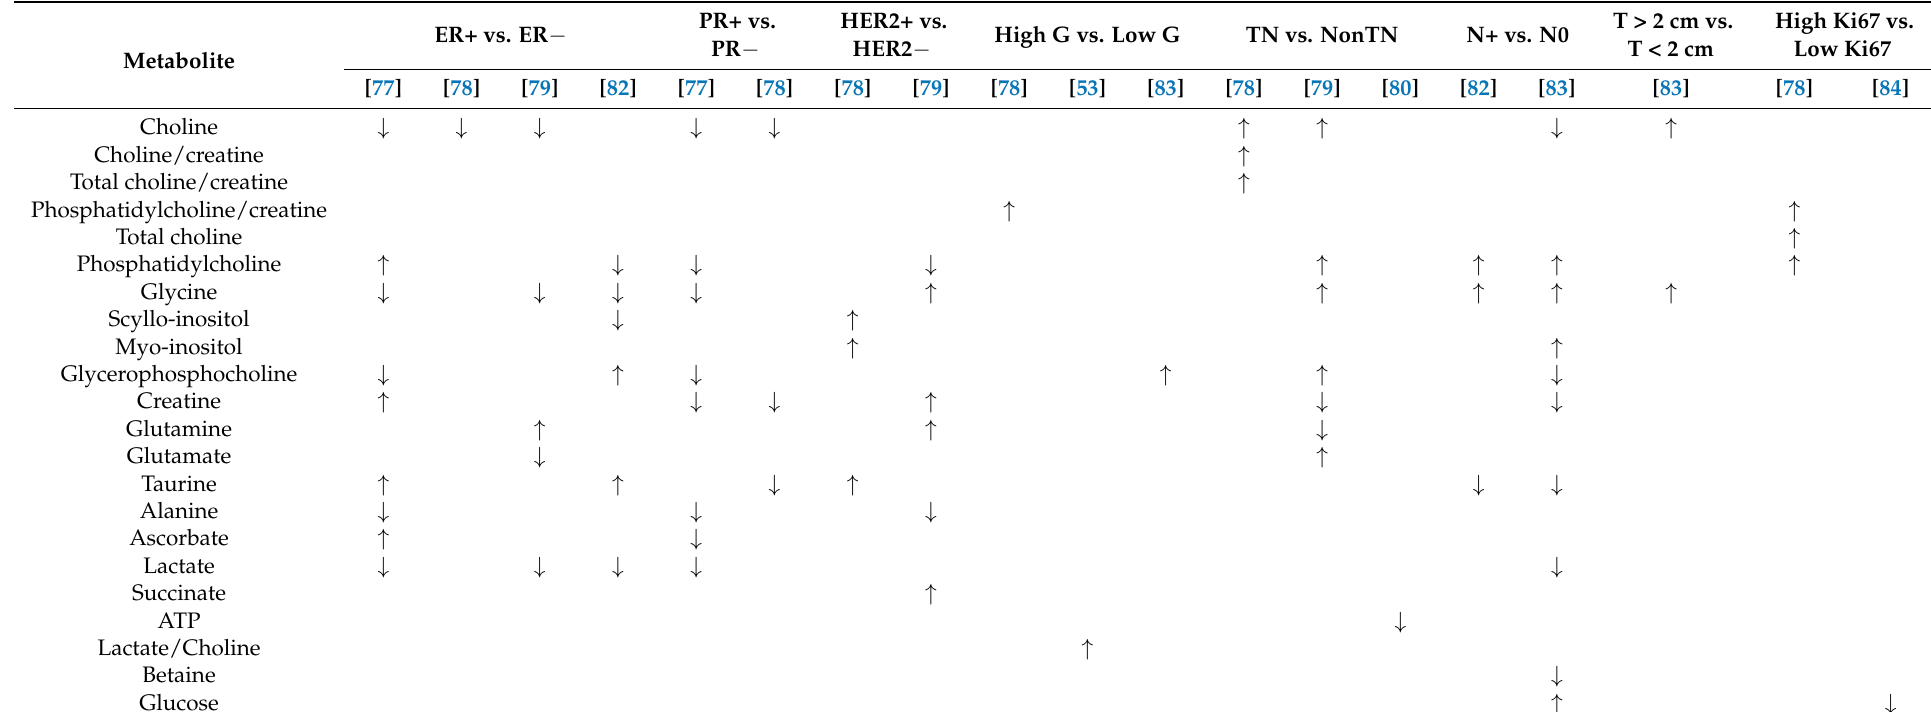
Table 3. List of altered metabolite levels identified in breast tissue of breast cancer patients to study clinicopathological factors.